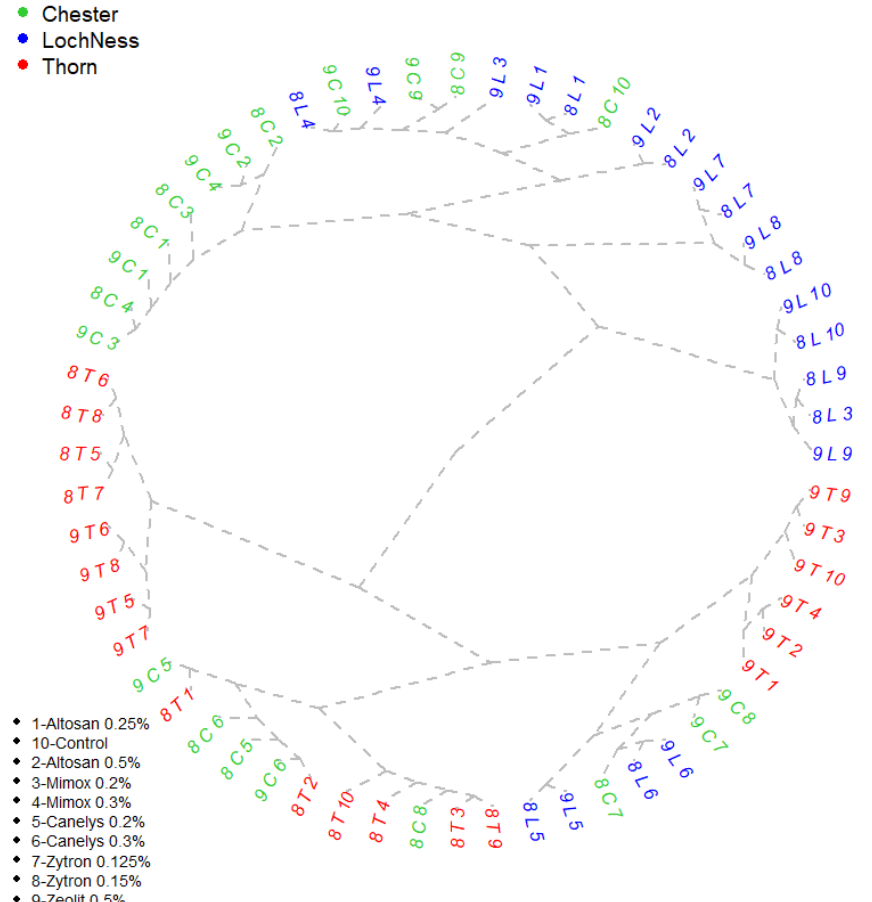
Figure 1. Cluster analysis of field treatments for organic blackberry rust disease control. First number represents the year: 8-2018; 9-2019 followed by the first letter taken from the variety’s name C-’Chester’; L-’Loch Ness’; T-’Thorn’. The second number represents the variant of treatment: V1-Altosan 0.25%; V2-Altosan 0.5%; V3-Mimox 0.2%; V4-Mimox 0.3%; V5-Canelys 0.2%; V6-Canelys 0.3%; V7-Zytron 0.125%; V8-Zytron 0.15%; 9-Zeolite 0.5%; V10-Control. A full description of treatment recipes is provided in Table 12.